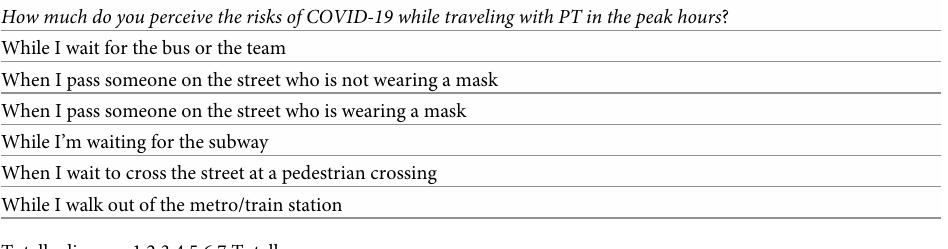
Table 2. The first subscale of the risk perception scale was used to measure risk perception related to the experi- ence of traveling in a PT